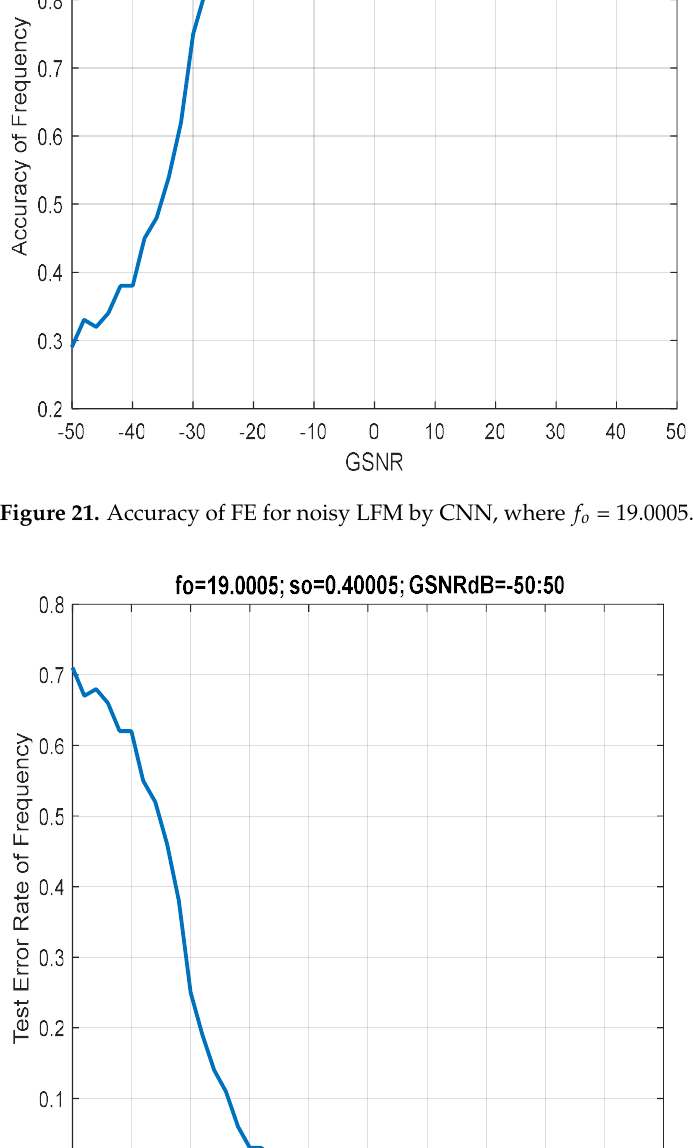
Figure 22. Test error rate of FE for noisy LFM by CNN, where f o =